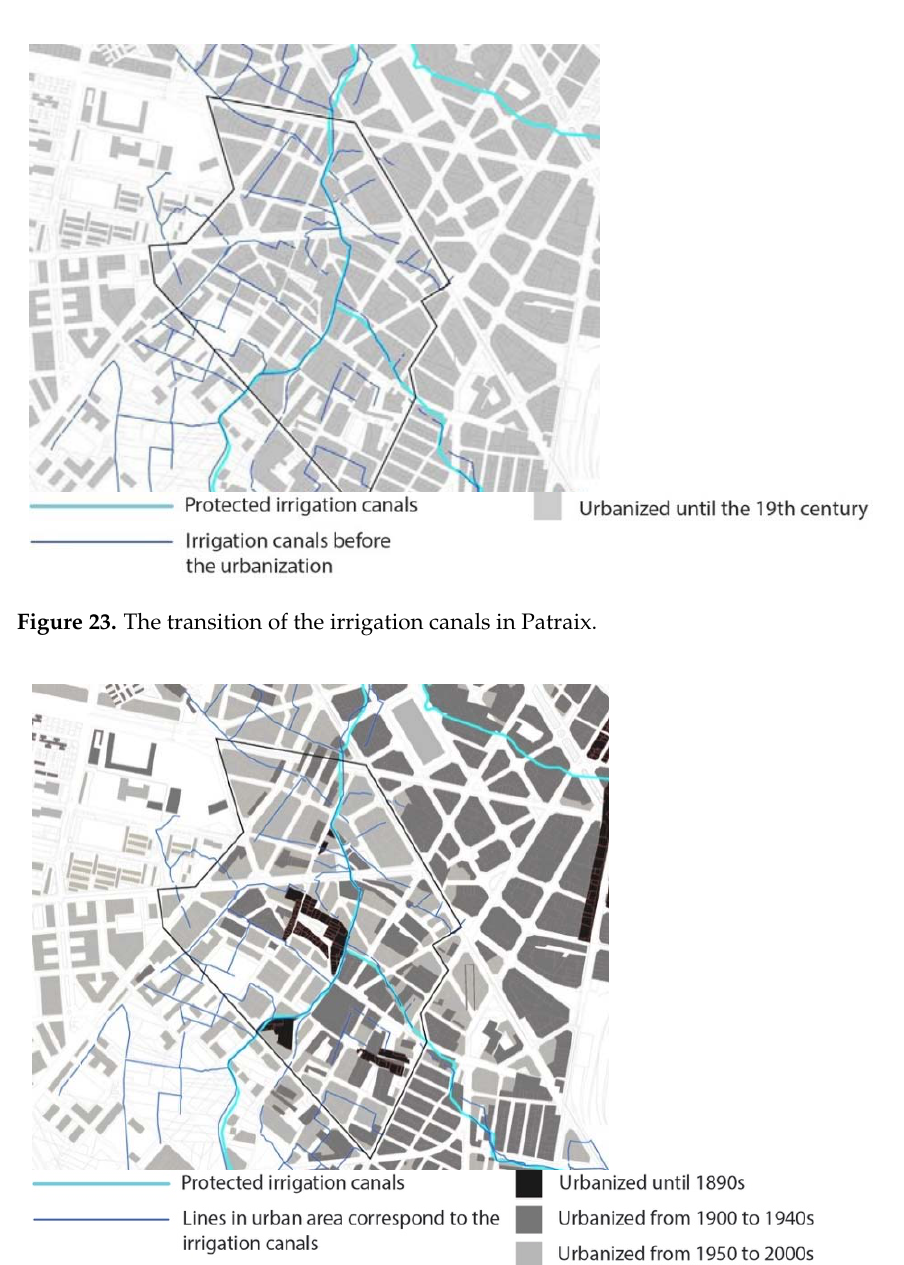
Figure 24. The transition of the irrigation canals and urban development in Patraix.